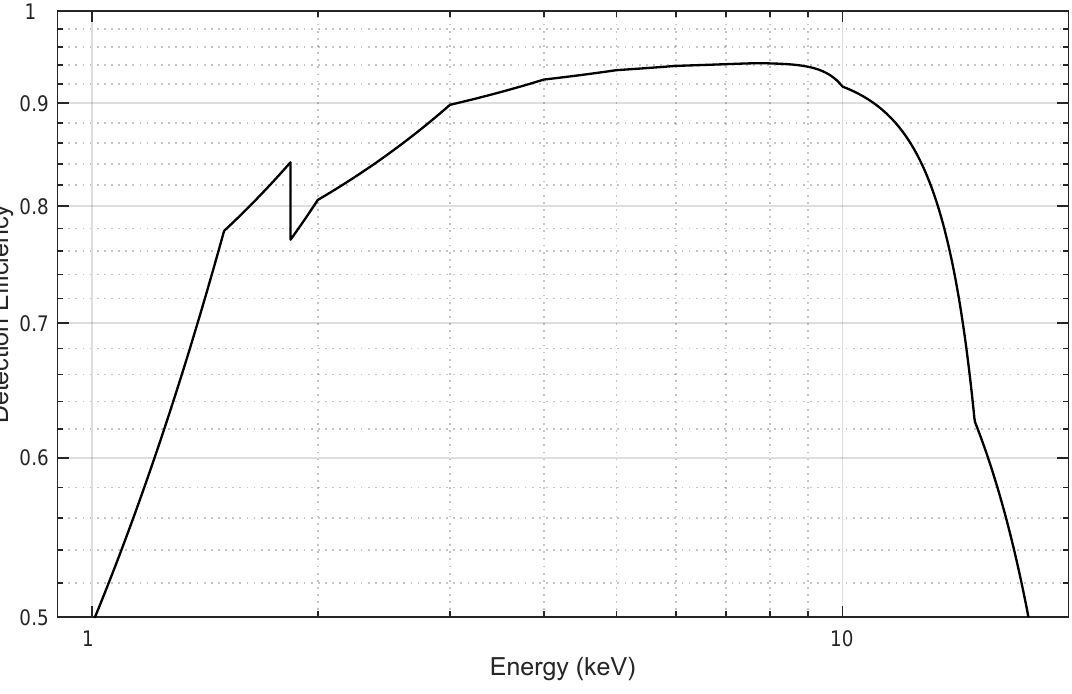
Figure 8. The X-ray detection efficiency curve of SDD with the incidence angle β = 0 ◦